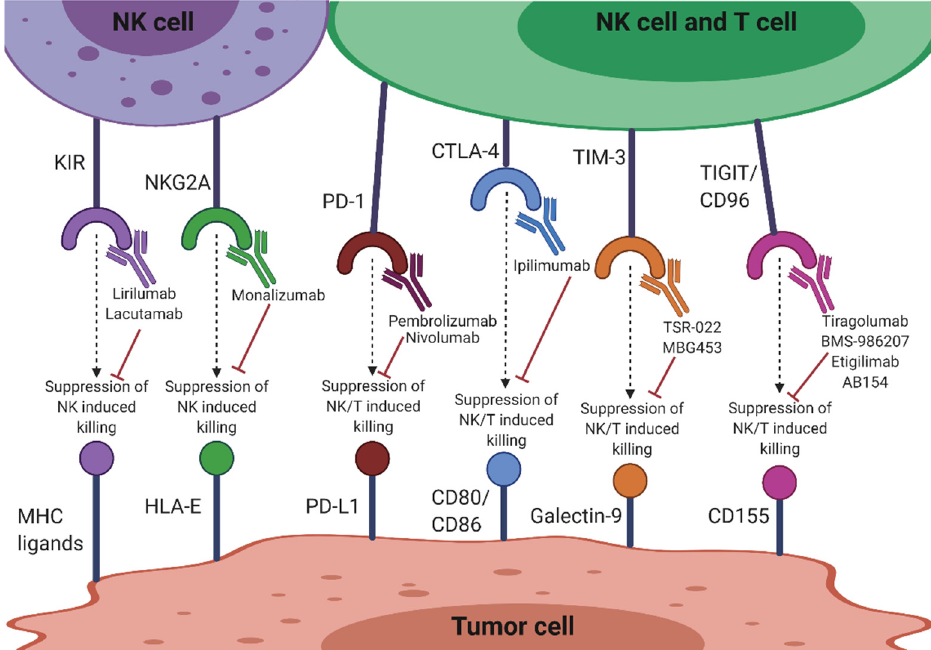
Figure 2. Checkpoint inhibitor targets in NK cells and T cells and their respective blocking antibodies under investigation for therapeutic efficacy and/or clinical use for cancer. Blocking antibodies act on their respective targets on NK cells and T cells to potentiate tumor cell killing. Abbreviations: CD, cluster of differentiation; CTLA-4, cytotoxic T-lymphocyte- associated protein 4; HLA-E, human leukocyte antigen-E; KIR, killer cell immunoglobulin-like receptors; MHC, major histocompatibility complex; NK, natural killer; NKG2A, CD94/NK group 2 member A; PD-1, programmed cell death protein 1; PD-L1, programmed death-ligand 1; TIGIT, T cell immunoreceptor with Ig and ITIM domain; TIM-3, T cell immunoglobulin and mucin domain-containing protein